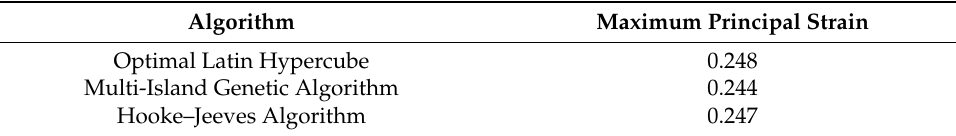
Table 7. Comparison of the sum of squared difference based on the optimization